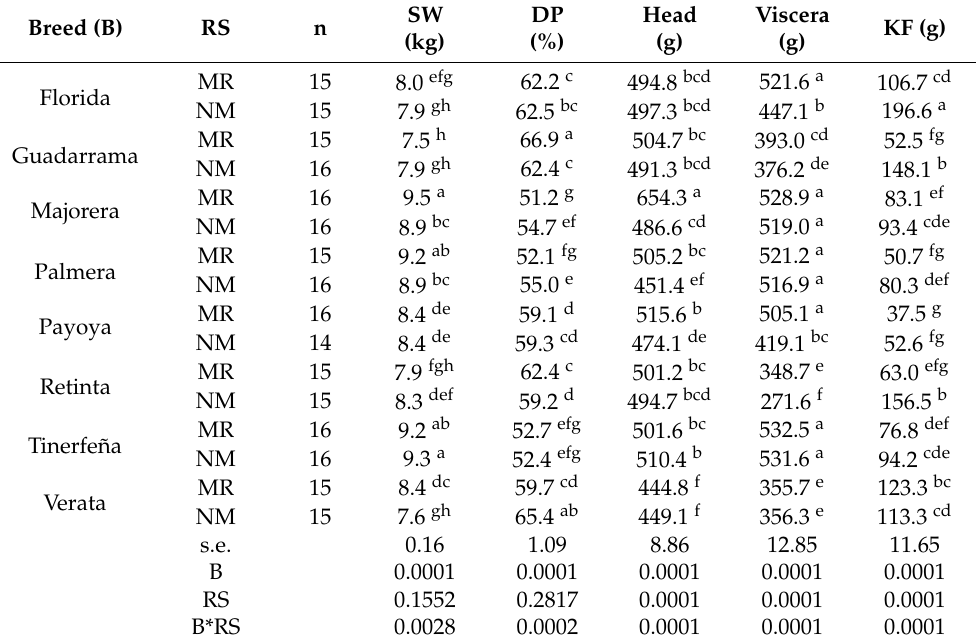
B, breed; RS, rearing system; SW, slaughter weight; DP, dressing percentage (HCW*100/SW); KF, kidney fat. s.e., standard error. Least square means were adjusted for an HCW of 4.965 kg. Different superscripts (a,b,c,d,e,f,g,h) indicate significant differences ( p <